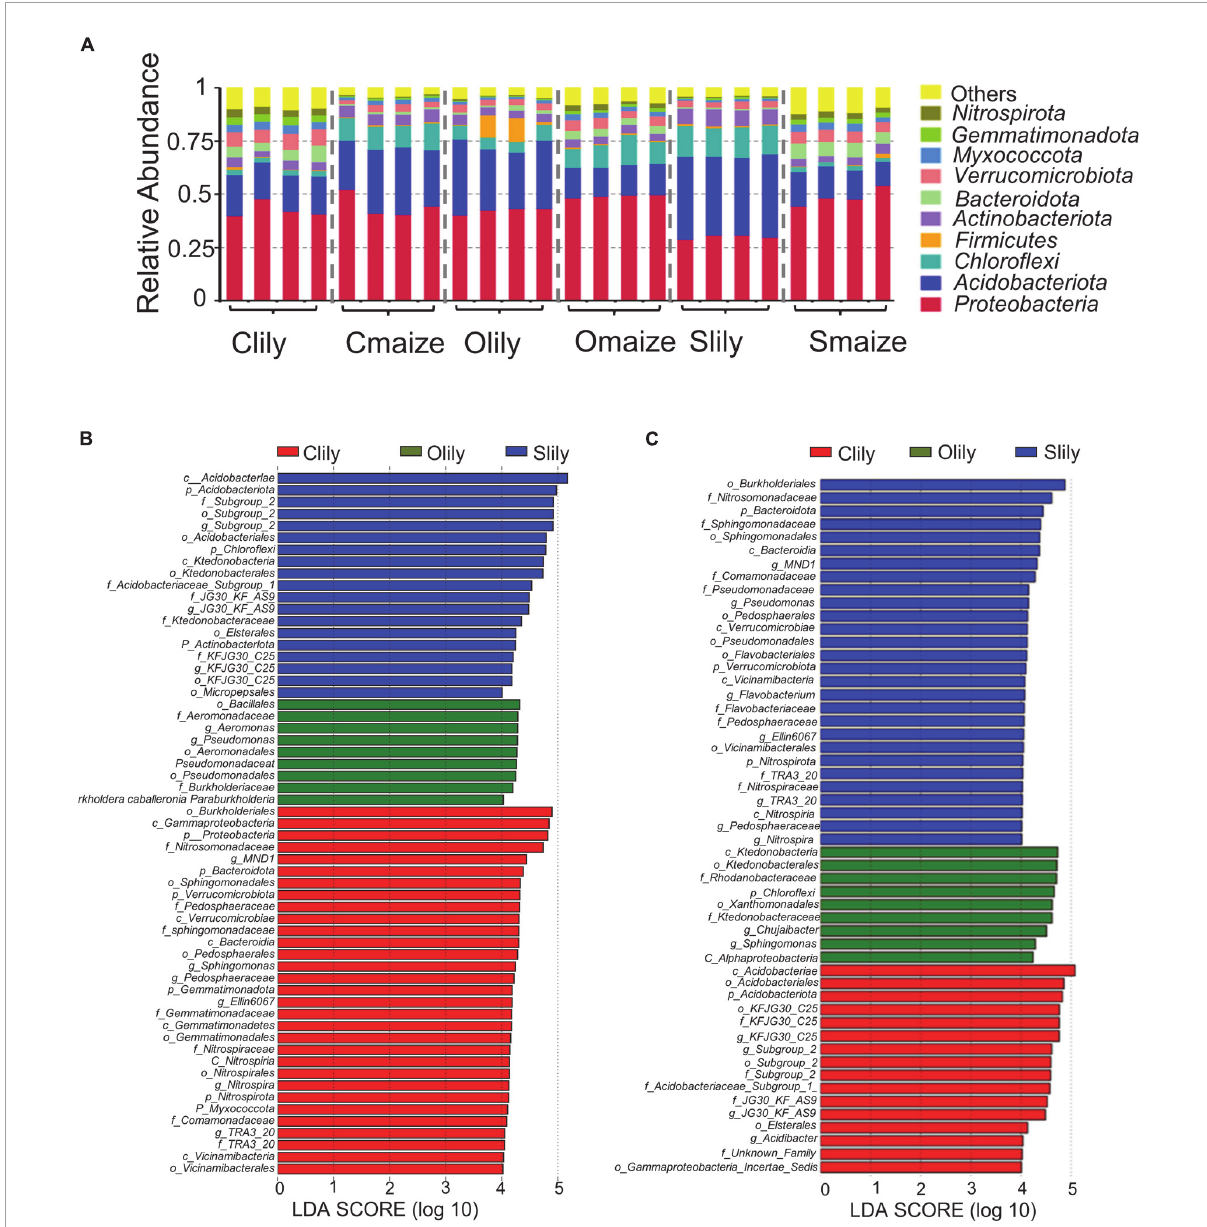
FIGURE3 The rhizosphere bacterial community structure presents intrinsic bias according to crop species and soil type. (A) Taxonomic diversity of the top 10 phyla in different samples. n = 4 biological replicates. (B) Histogram of LDA scores of 16S rRNA sequences of tiger lily rhizosphere microbiome. (C) Histogram of LDA scores of 16S rRNA sequences of maize rhizosphere microbiome. The LDA value distribution histogram shows species whose LDA score is greater than 4, indicating a biomarker with statistical difference between the groups. The length of the histogram represents the impact size of the different